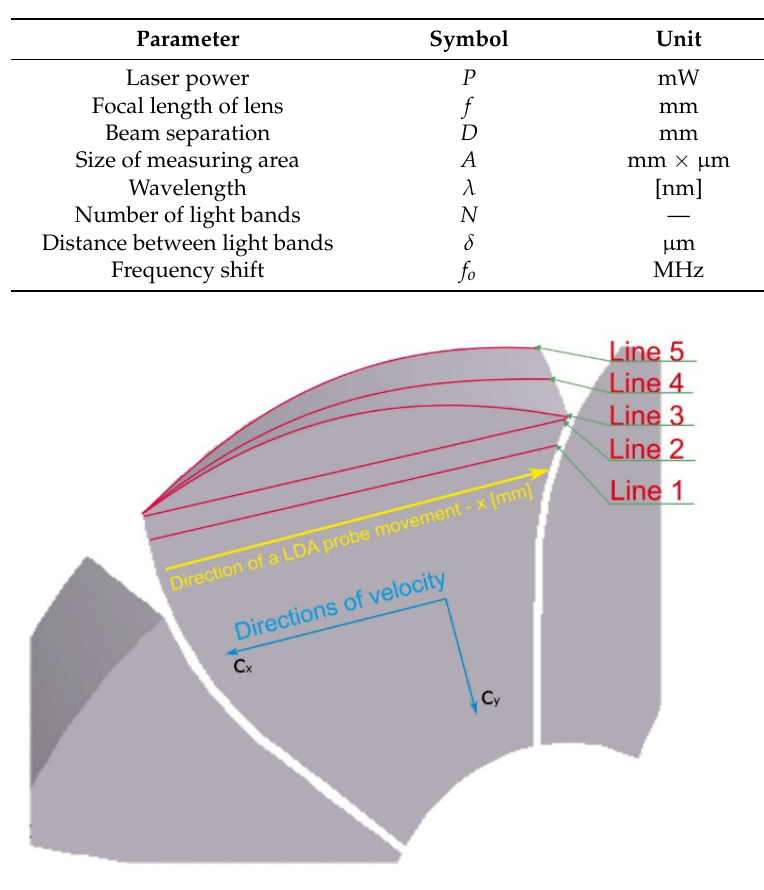
Table 4. Technical data of the DANTEC 60X laser anemometer.